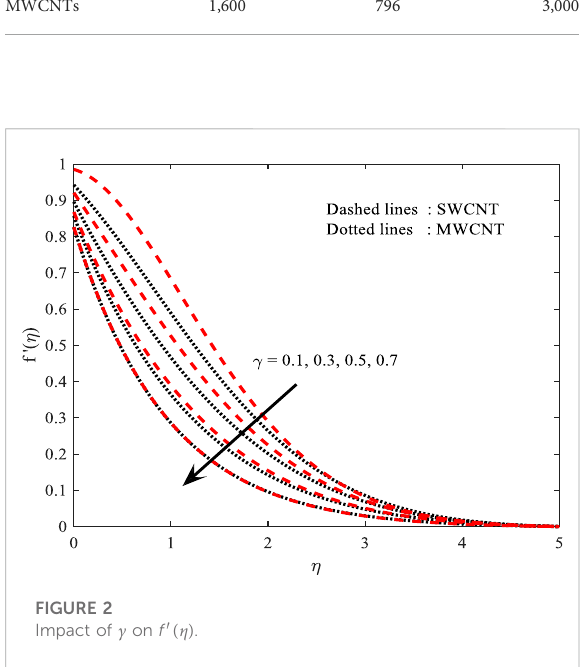
FIGURE 2 Impact of γ on f ′ ( η )